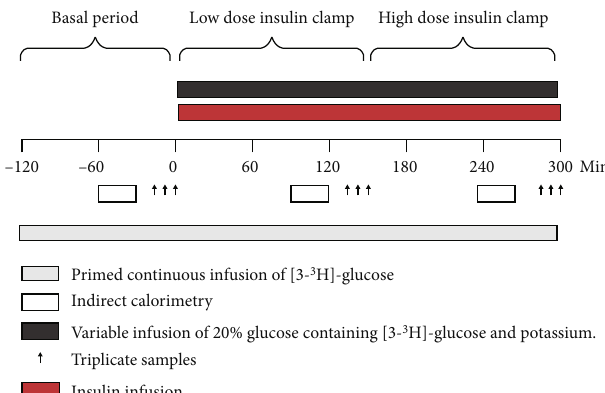
Figure 1: Graphical illustration of the two-step hyperinsulinemic euglycemic clamp. Abbreviations: LBM: lean body